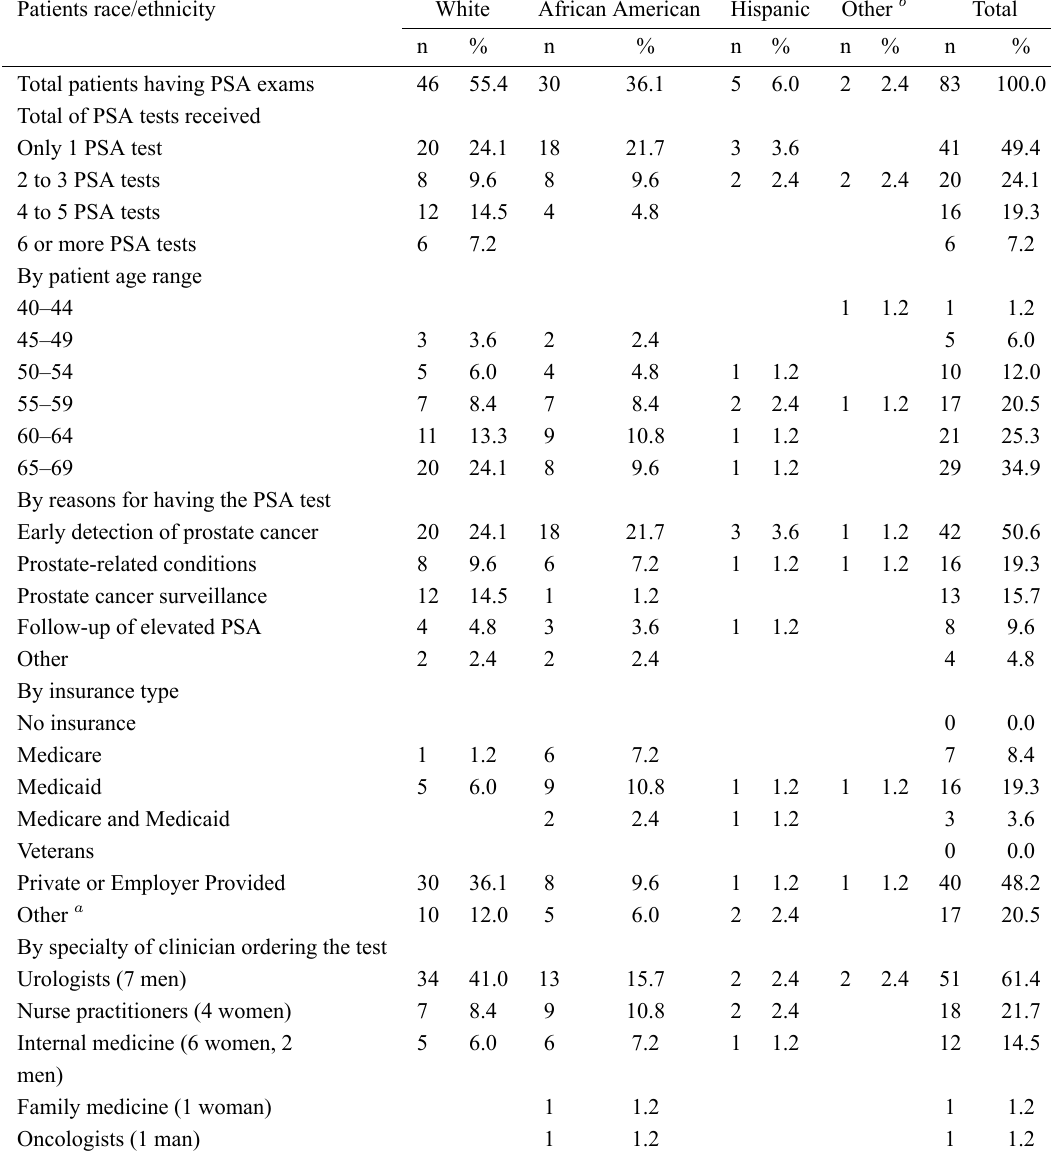
Table 3. Patients who had PSA tests